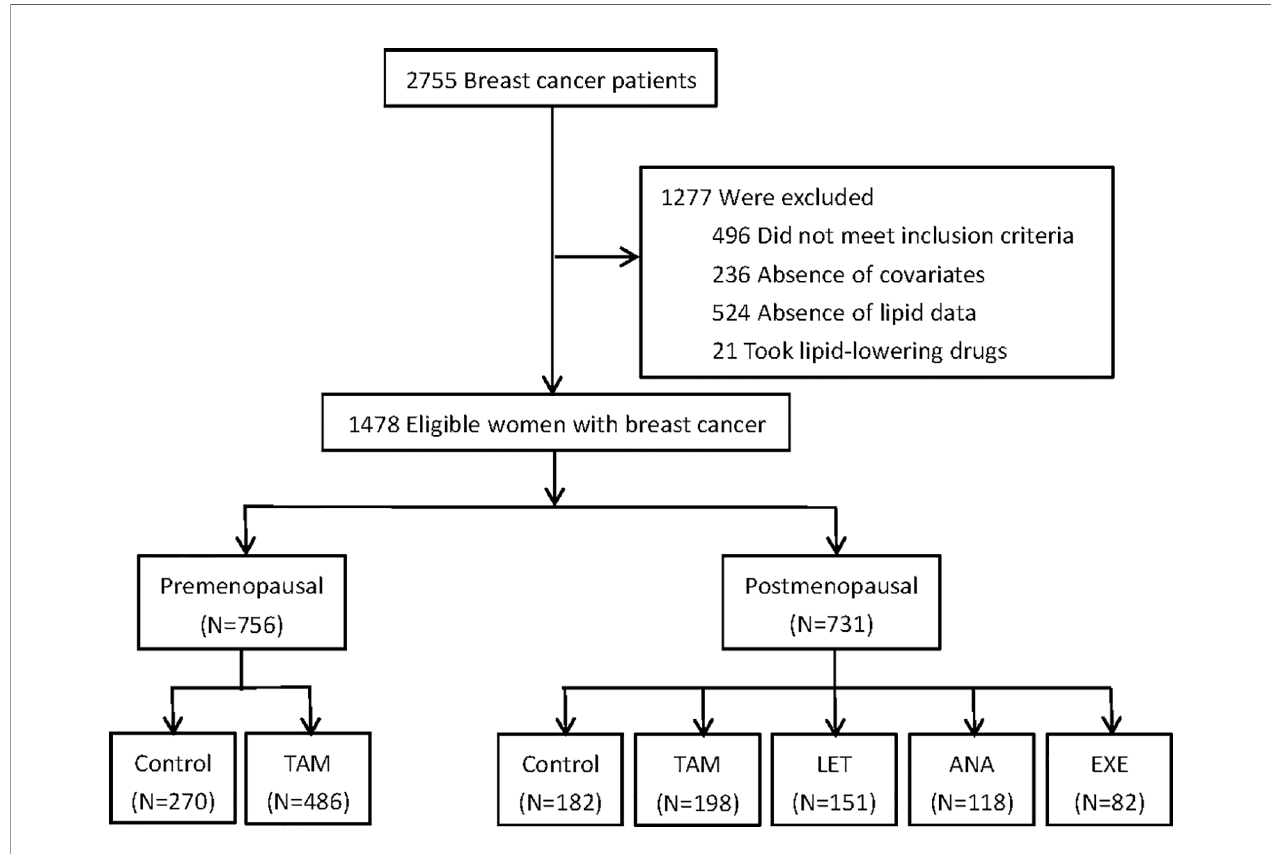
FIGURE 1 | Flow chart of included and excluded patients.